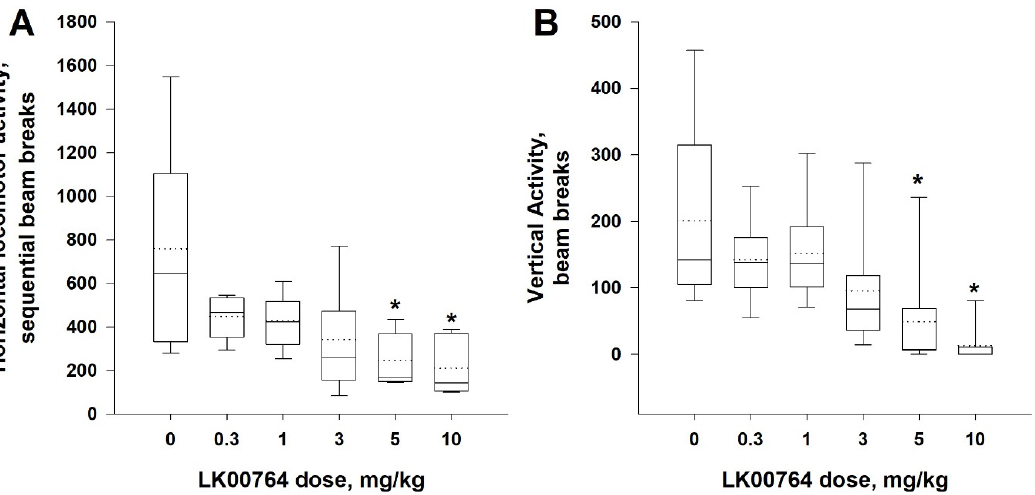
Figure 4. Effect of compound 62 (LK00764) on MK-801-induced hyperactivity. The mitigation action of LK00764 (0.3–10 mg/kg, i.p.) on locomotor hyperactivity following MK-801 (0.2 mg/kg, i.p.) administration in rats (n = 7). ( A ). Horizontal activity ( B ). Vertical activity. Data are represented as medians (solid lines), means (dotted lines), and 25th and 75th percentiles in a box-whisker plot, with whiskers indicating 10th and 90th percentiles. * p < 0.05 (Dunnett’s test) compared with vehicle treatment.